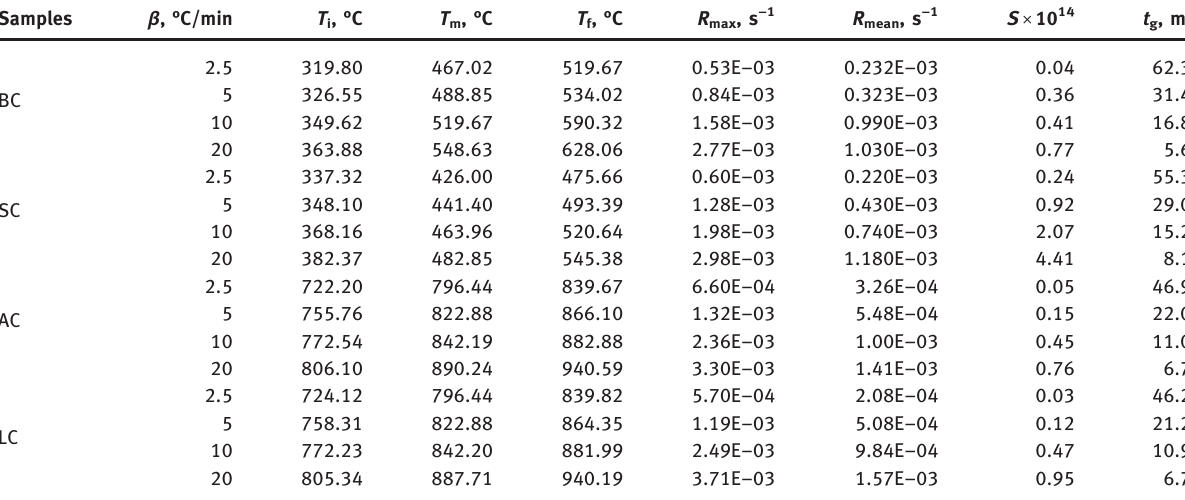
Table 2: Combustion characteristic parameters of different samples under different heating rates.